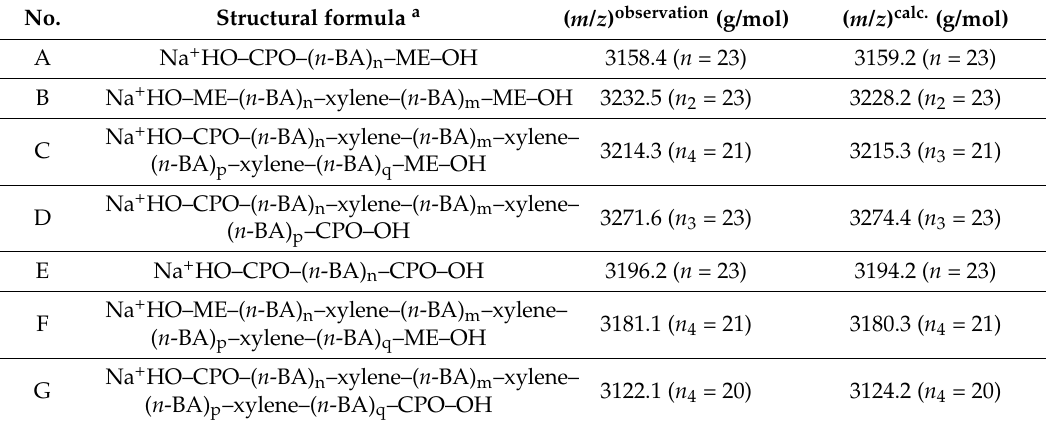
Table 2. Structural formulas of the PBA produced in DITP of n -BA, depicted based on MALDI-TOF Mass